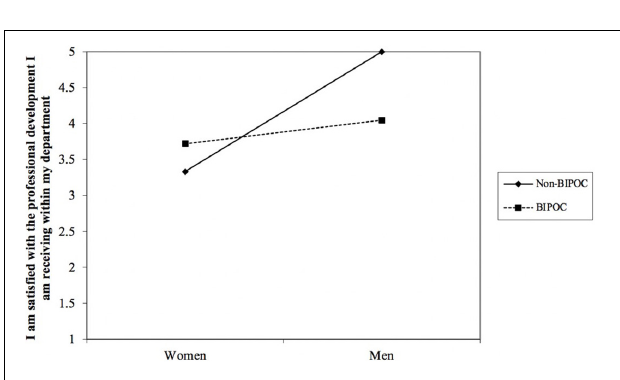
FIGURE 5 | Gender interacting with BIPOC to predict MSU environment item “I am satisfied with the professional development I am receiving within my